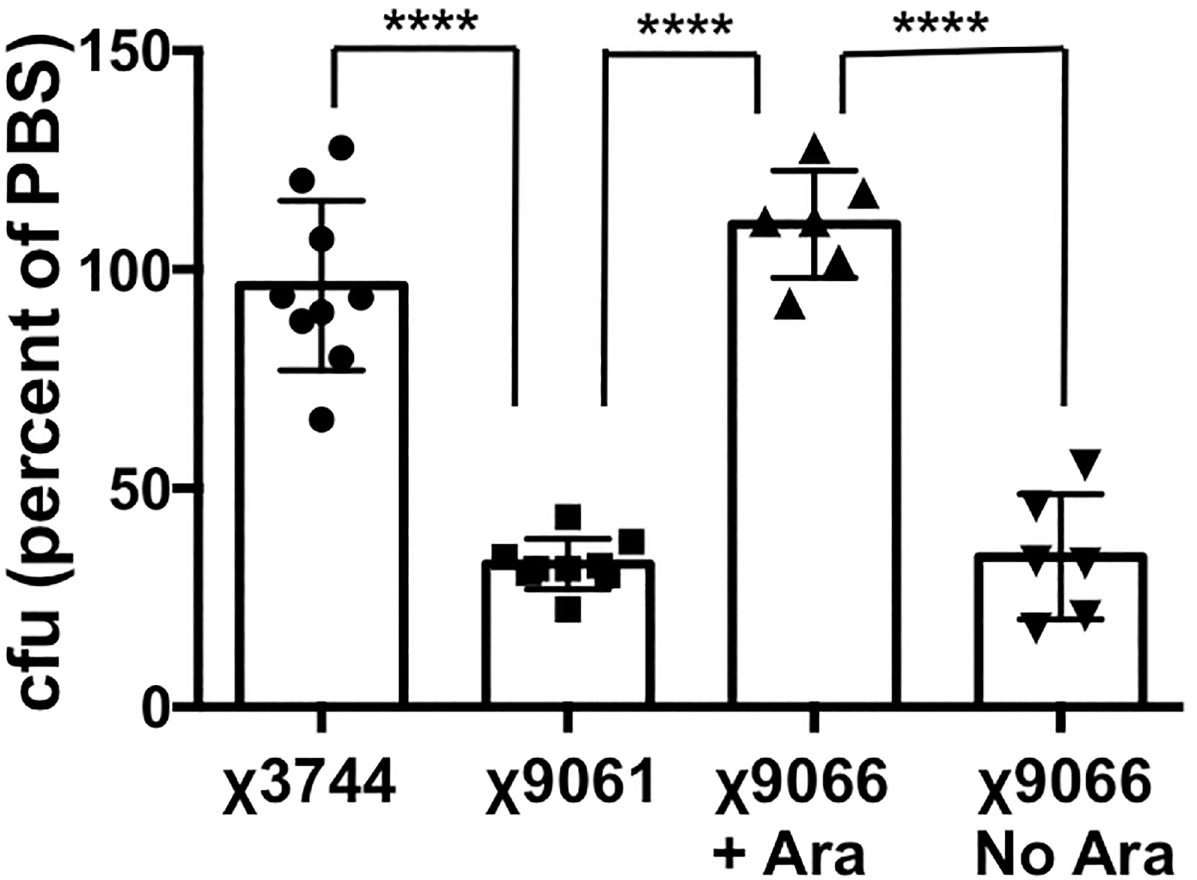
Fig 7. rpoS is required for survival of S . Typhi in water. Equivalent numbers of the S . Typhi strains χ 3744 (wild-type rpoS ), χ 9061 ( rpoS inactivated), χ 9066 (arabinose-inducible rpoS ), grown overnight in shaking cultures (with our without added arabinose–Ara–in the case of χ 9066, as indicated), were incubated in PBS or in sterile distilled water for 1 hour at 37˚C. The number of bacteria surviving in water was expressed as a percentage of the number in PBS for each strain (the values for PBS are not shown for ease of visualization). ���� p < 0.0001, n = 6–9 per group.